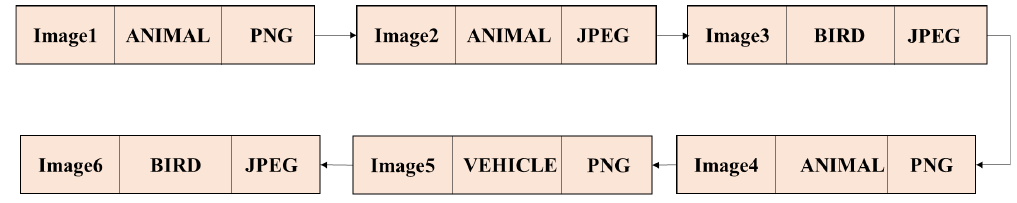
Figure 4. Linked list formed for the records in JSON document by